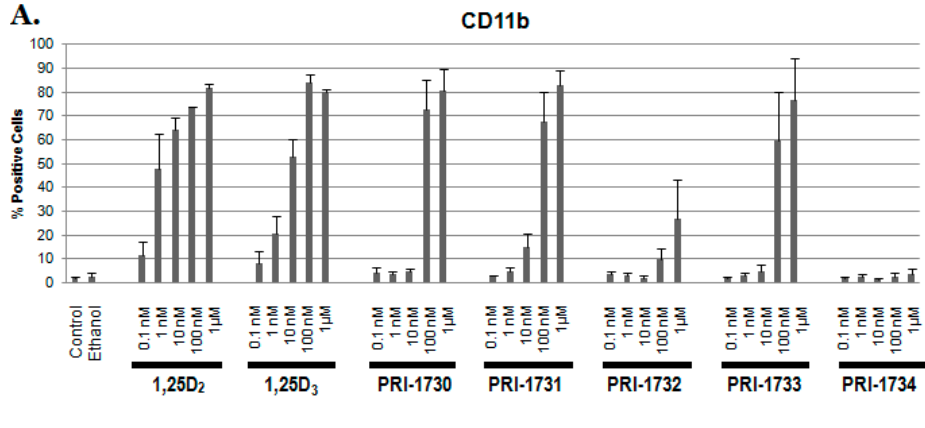
Figure 2. Cont. Figure 3. Cont